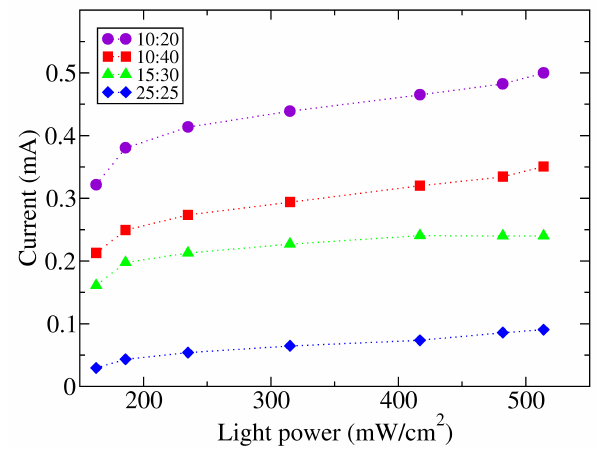
guides for the eye.